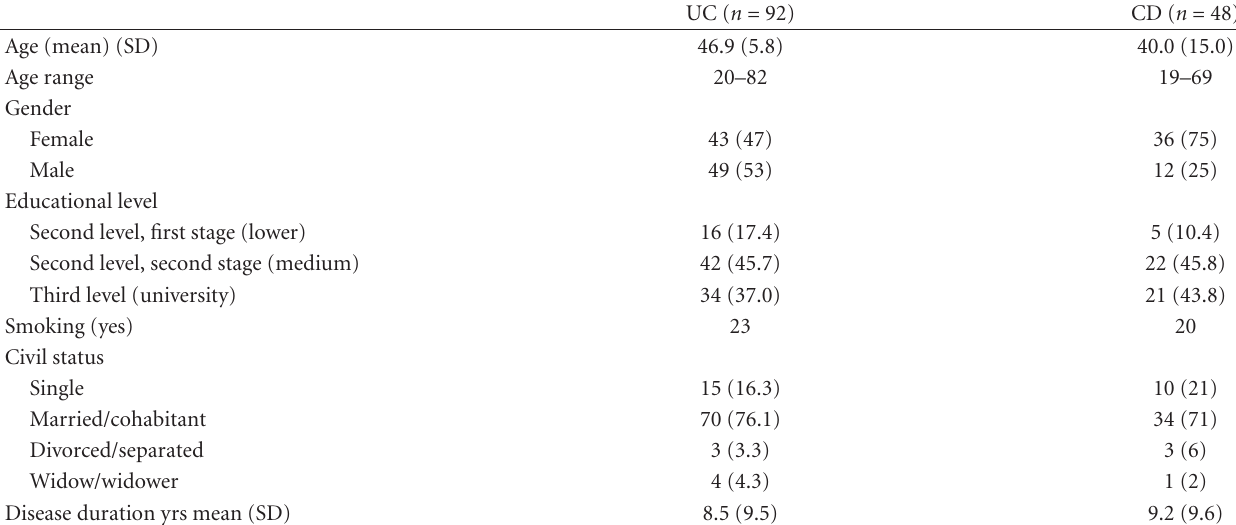
Table 1: Primary Sociodemographic and clinical data at study entry